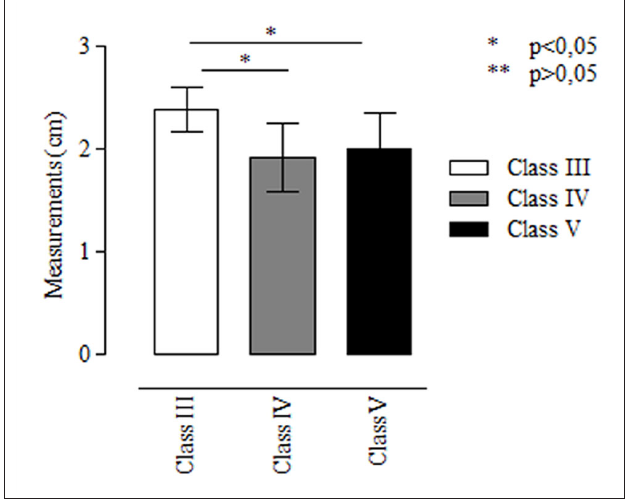
Fig. 3. Association between the classification of edentulous jaws - III, IV and V - and the measures of mandibular bone height.